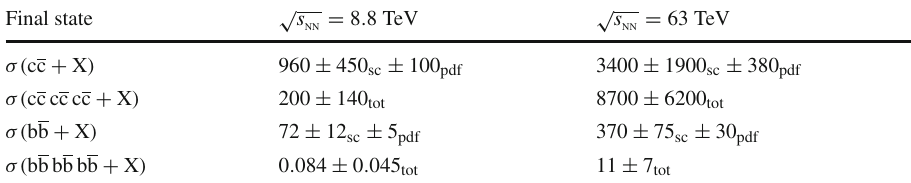
bottom SPS (NNLO) and TPS cross sections (in mb) in pPb at LHC and FCC energies with scales (“sc”), PDF, and total (quadratically added, including σ eff , tps ) uncertainties